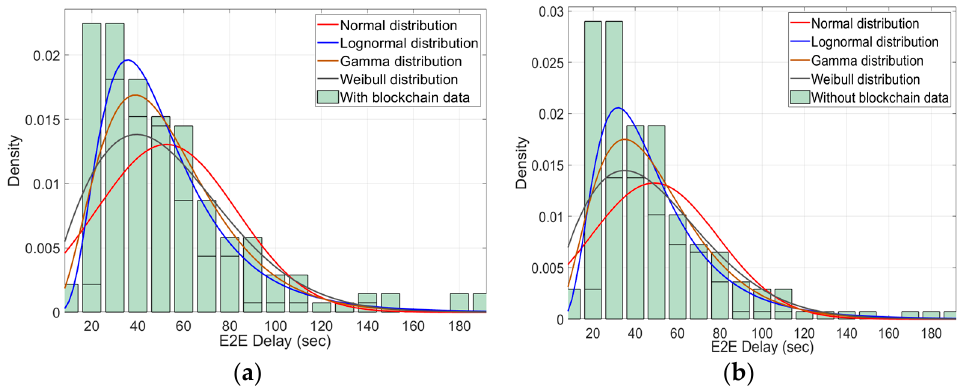
Figure 12. ( a ): E2E delay for the BEST framework; ( b ) E2E delay for the centralised PES system.